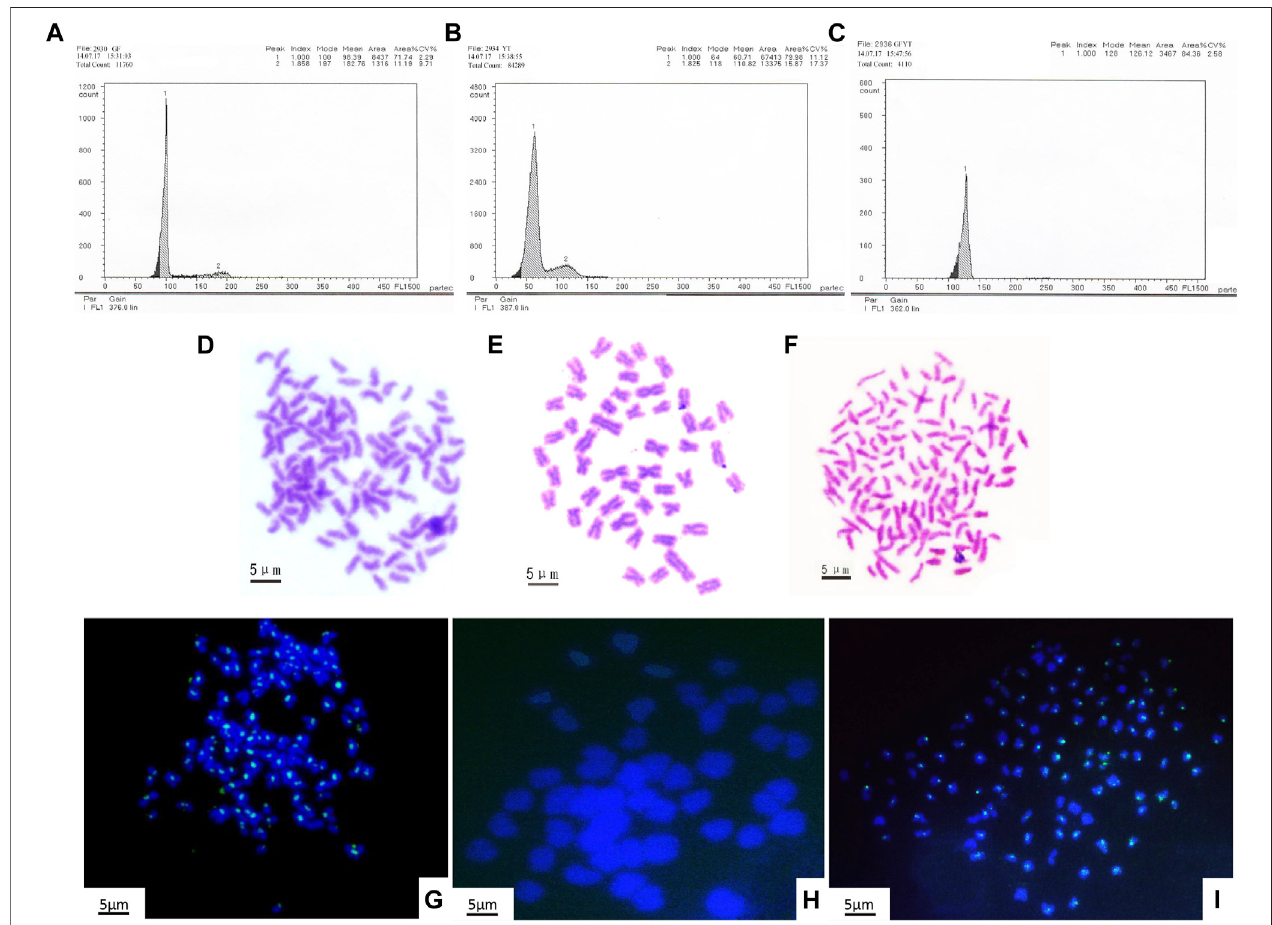
FIGURE2| FlowcytometrichistogramsandchromosomalconstitutionofGFYThybridsandtheirparents. (A – C) MeanDNAcontent. (A) GF(peak1:98.39). (B) YT (peak 1: 60.71). (C) GFYT hybrids (peak 1: 126.12). (D – F) Chromosome spreads at metaphase. (D) 100 chromosomes of GF. (E) 48 chromosomes of YT. (F) 124 chromosomes of GFYT hybrids. (G – I) Fluorescence in situ hybridization of mitotic metaphase chromosomes. (G) GF, about 100 signals. (H) YT, no signal. (I) GFYT, about 100 signals.